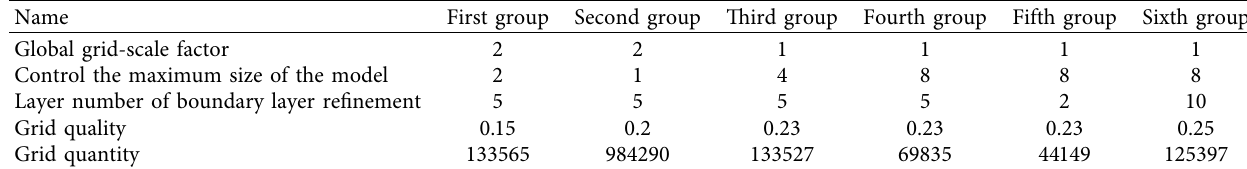
Table 8: Results of impeller grid division.